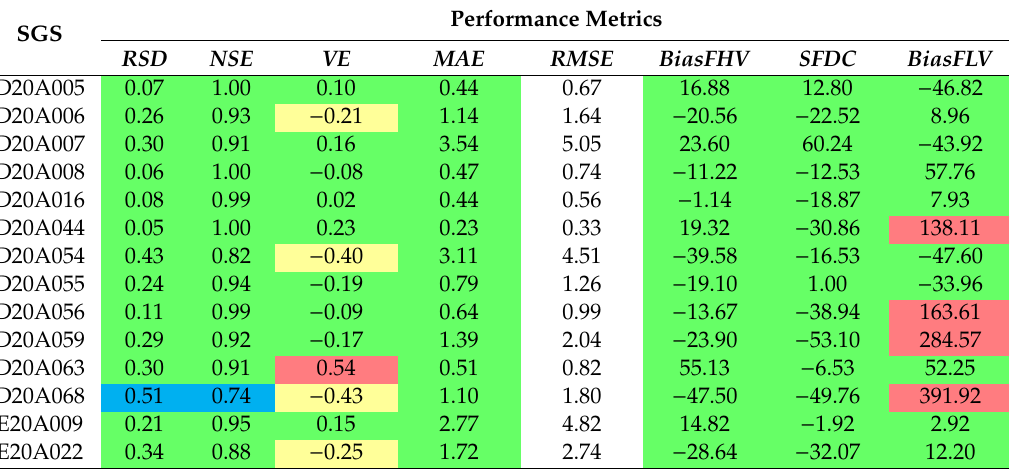
Table 10. Performance metrics for the validation streamflow gauging stations (colors refer to the performance of the model; green: very good, blue: good, yellow: adequate, red: inadequate).